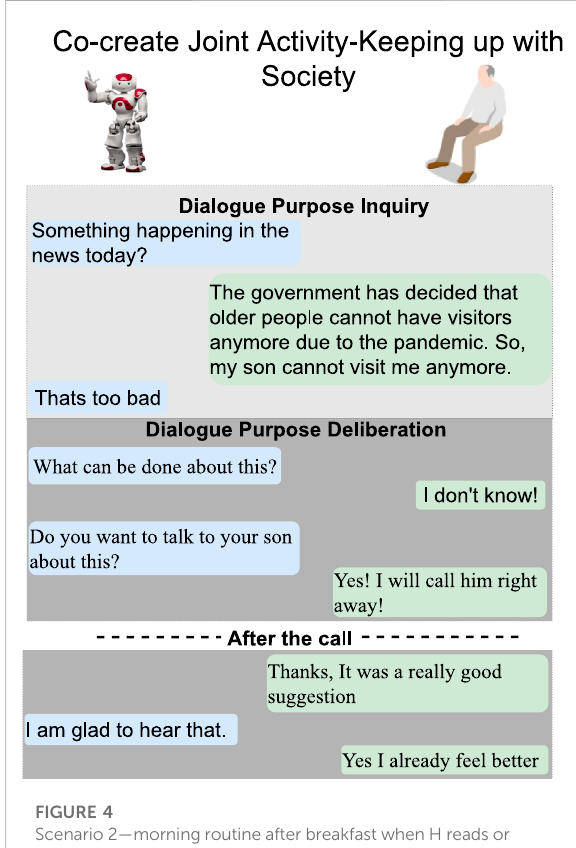
FIGURE 3 Scenario 1 — morning routine including dialogue topics on general well-being and breakfast. R asks H how he/she is feeling fi rst thing in the morning. When H indicates that he/she is not feeling well, R initiates a dialogue about why H is not feeling well. H rejects R ’ s proposal to talk about health, which causes a breakdown situation due to con fl icting motives ( restoring D in Figure 2). Text highlighted in blue represents R ’ s utterances and text in green is H ’ s utterances.